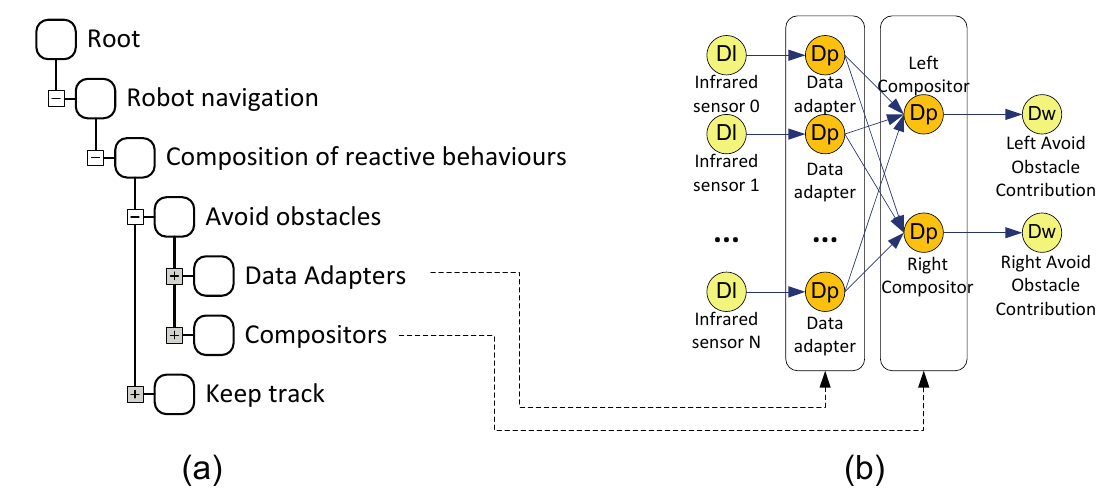
Figure 4. ( a ) Control Component Tree; ( b ) Logical Sensor